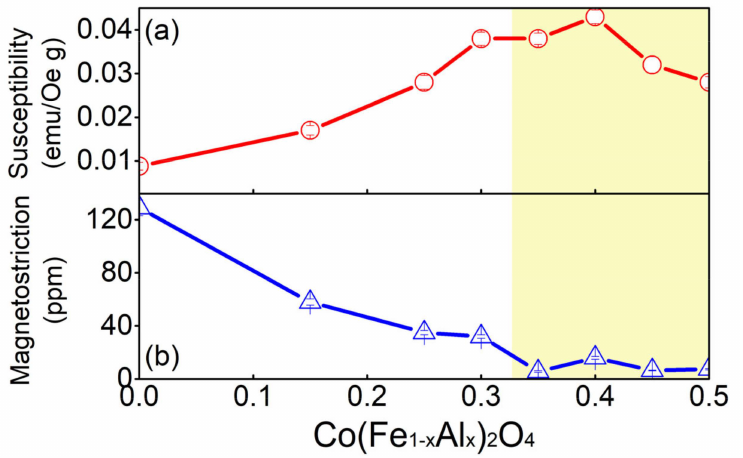
Figure 7. (Color online). Composition dependence of magnetic susceptibility ( a ) and saturated magnetostriction ( b ) at room temperature. The yellow-shadowed region denotes the composition range that exhibits high magnetic susceptibility and low